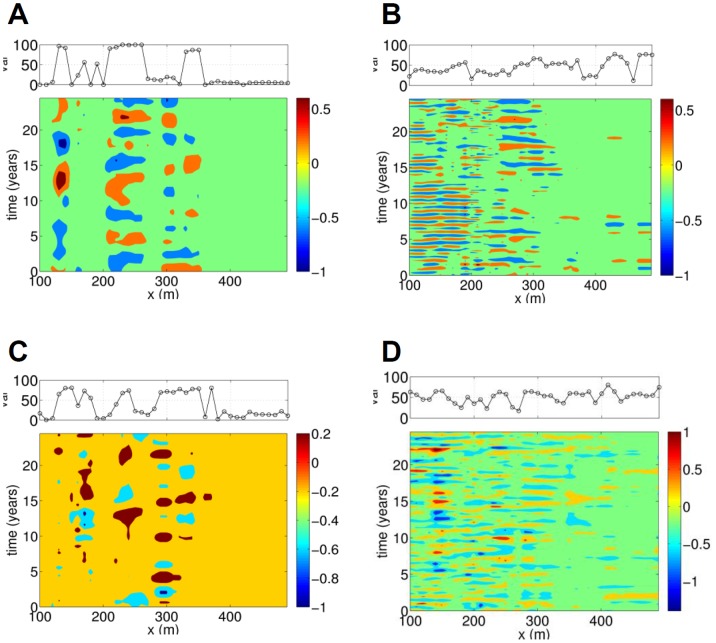
LPOs and SPOs and their resolved variance (top) for transects 58 (LPOs shown in A; SPOs in B) and 190 (LPOs shown in C; SPOs in D).